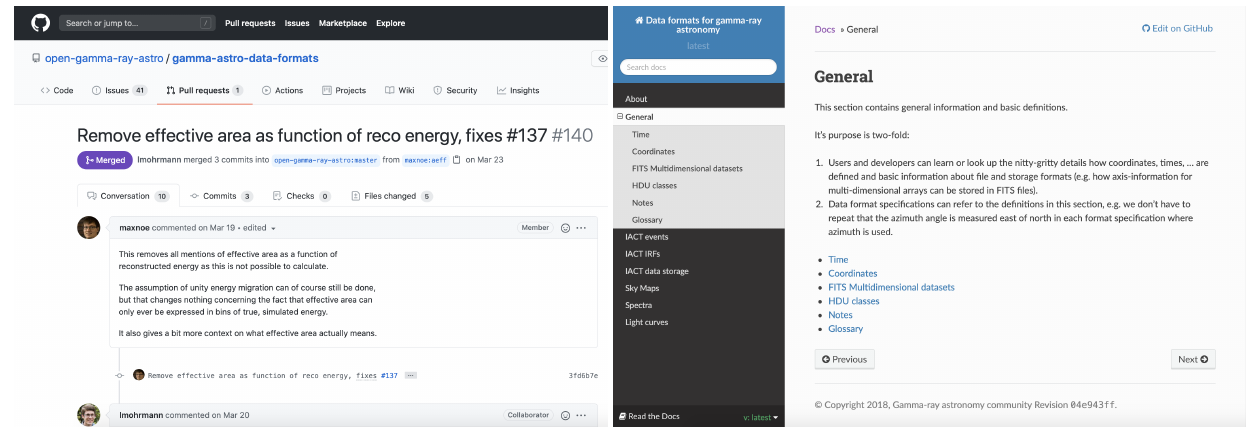
Figure 2. ( Left ): GitHub repository hosting the development of the data formats for gamma-ray astronomy specifications. ( Right ): The repository contains a documentation written in sphinx whose html version can be explored on readthedocs